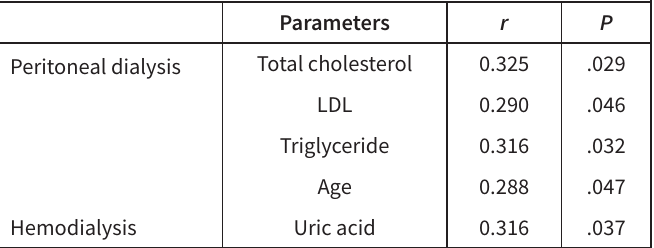
Table 3. Correlation Analysis Between Urotensin II and Parameters